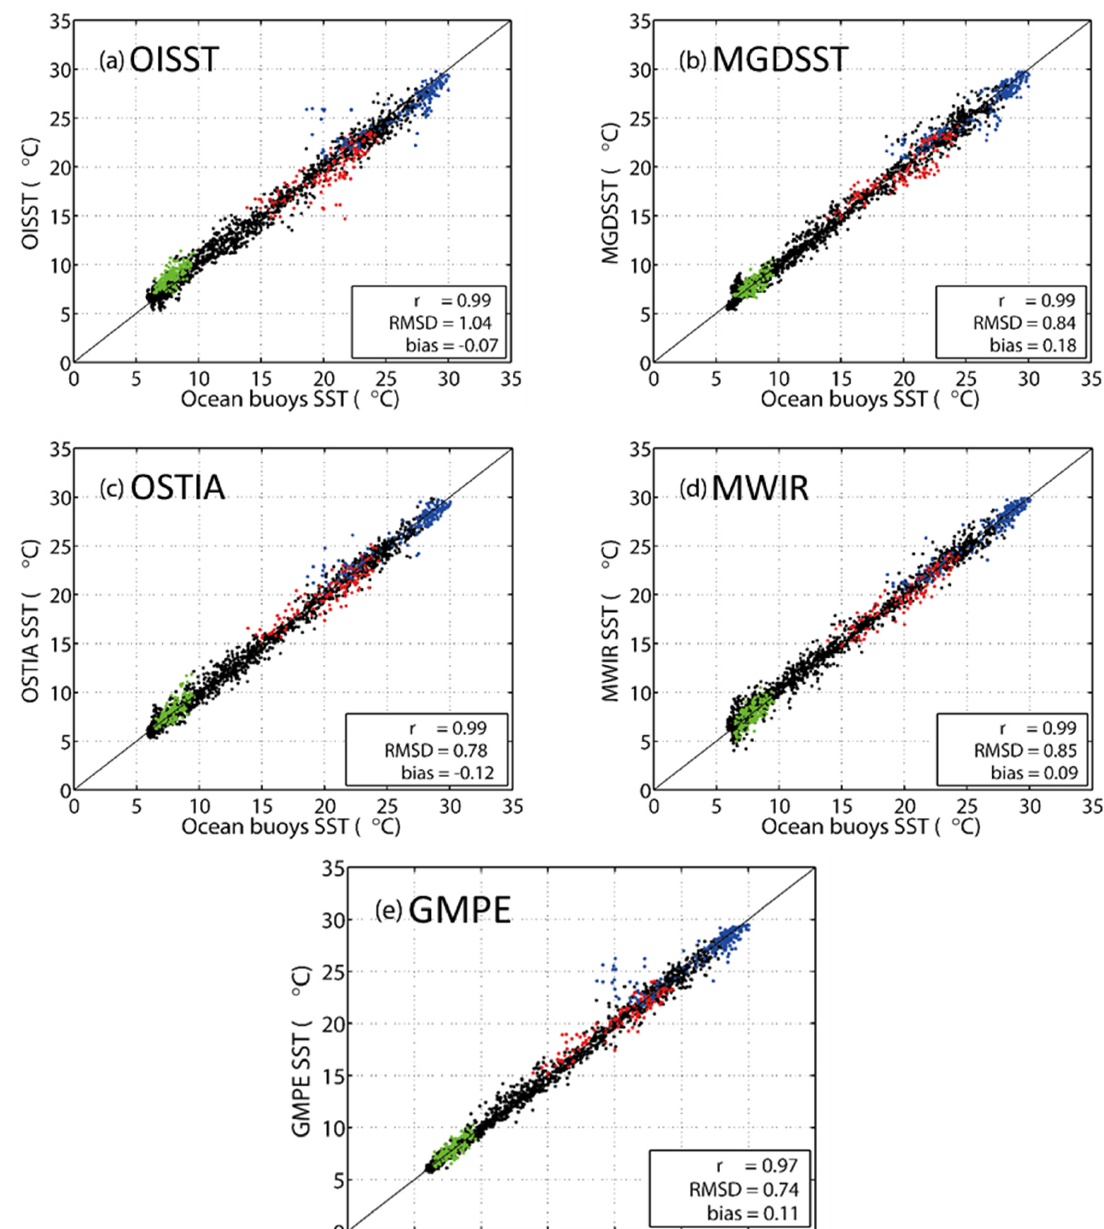
Figure 2. Comparison between the SST (°C) data measured by ocean buoys (KB and SB) and the global gridded SST products (OISST, MGDSST, OSTIA, MWIR, and GMPE). Red, blue, green, and black dots correspond to the SSTs observed in June, August, December, and other months, respectively. r is the correlation coefficient.